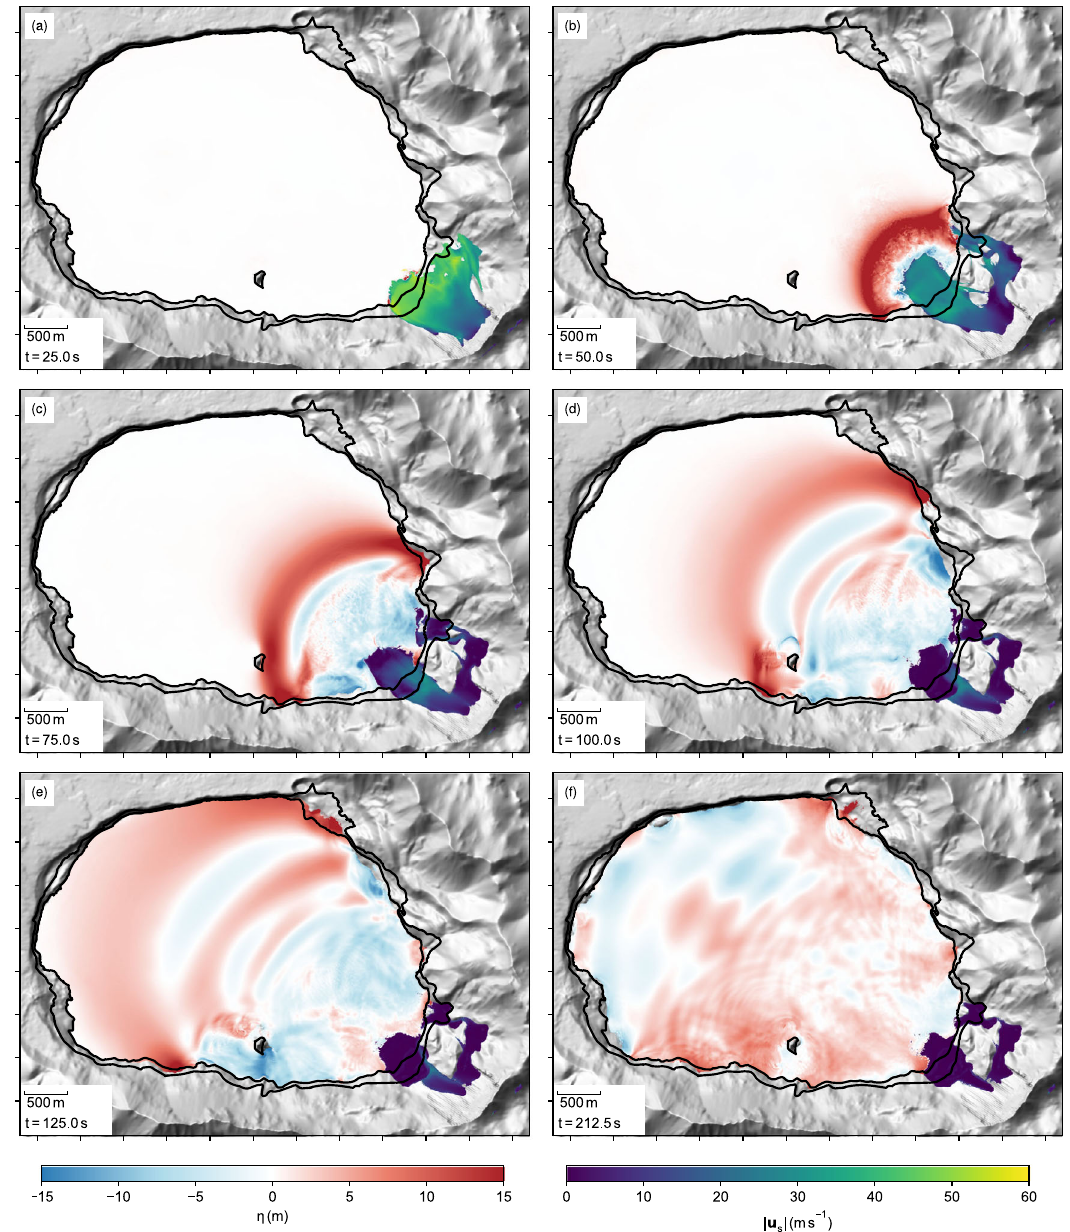
Fig. 6 The simulated Lake Askja landslide tsunami. a – f The water surface is represented by the iso-surface ϕ w /( ϕ w + ϕ a ) = 0.5 and the surface elevation η is calculated as the difference to the surface at rest at z = 1058.25m. The dense core of the landslide is shown similar as in Fig. 5. For an animated version see supplemented movies 3 (top view) and 4 (perspective